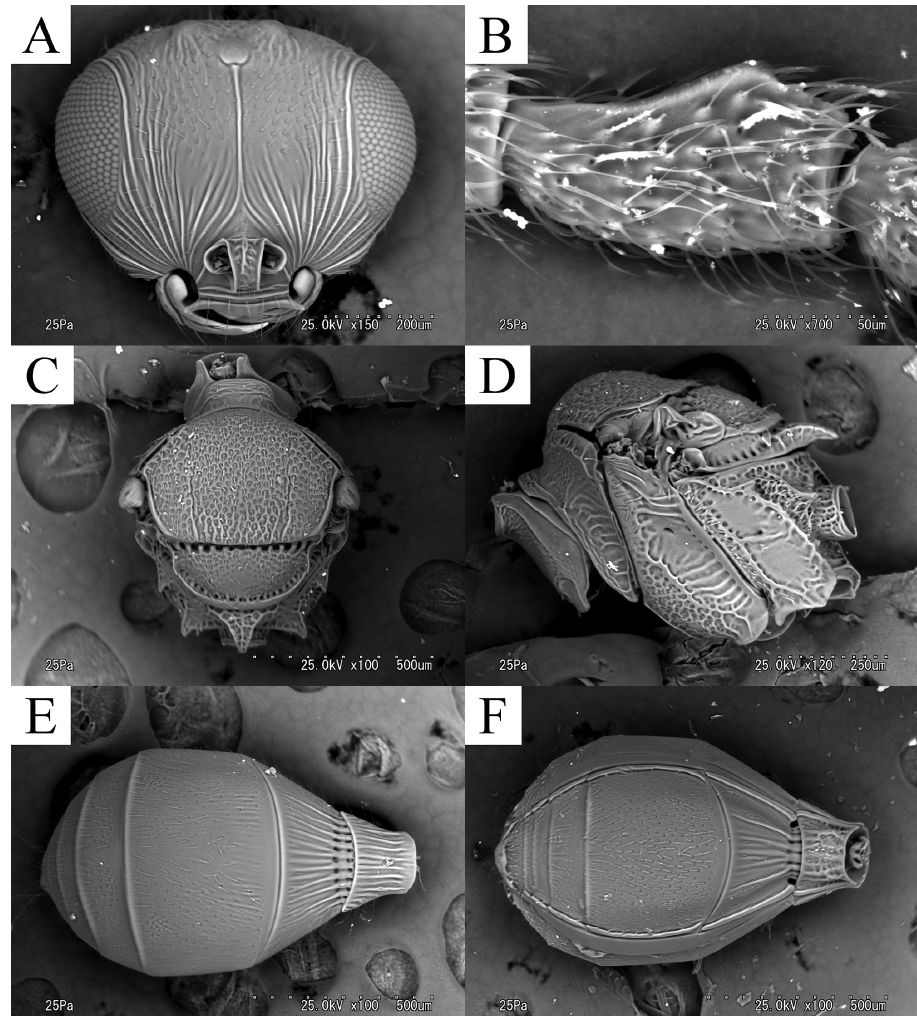
Figure 8. Trimorus haniyasu sp. n., male. A head, frontal view B A5, lateral view C mesosoma, dorsal view D mesosoma, lateral view E metasoma, dorsal view F metasoma, ventral view.